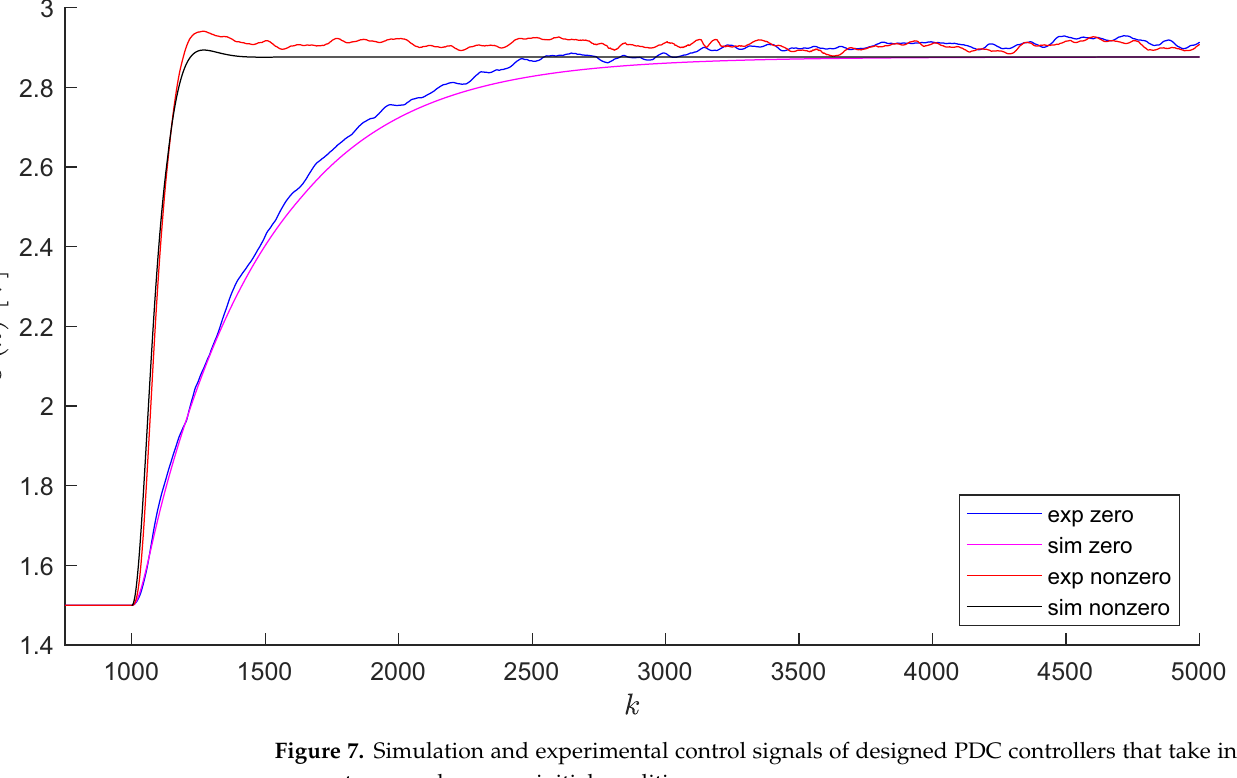
Figure 7. Simulation and experimental control signals of designed PDC controllers that take into account zero and nonzero initial